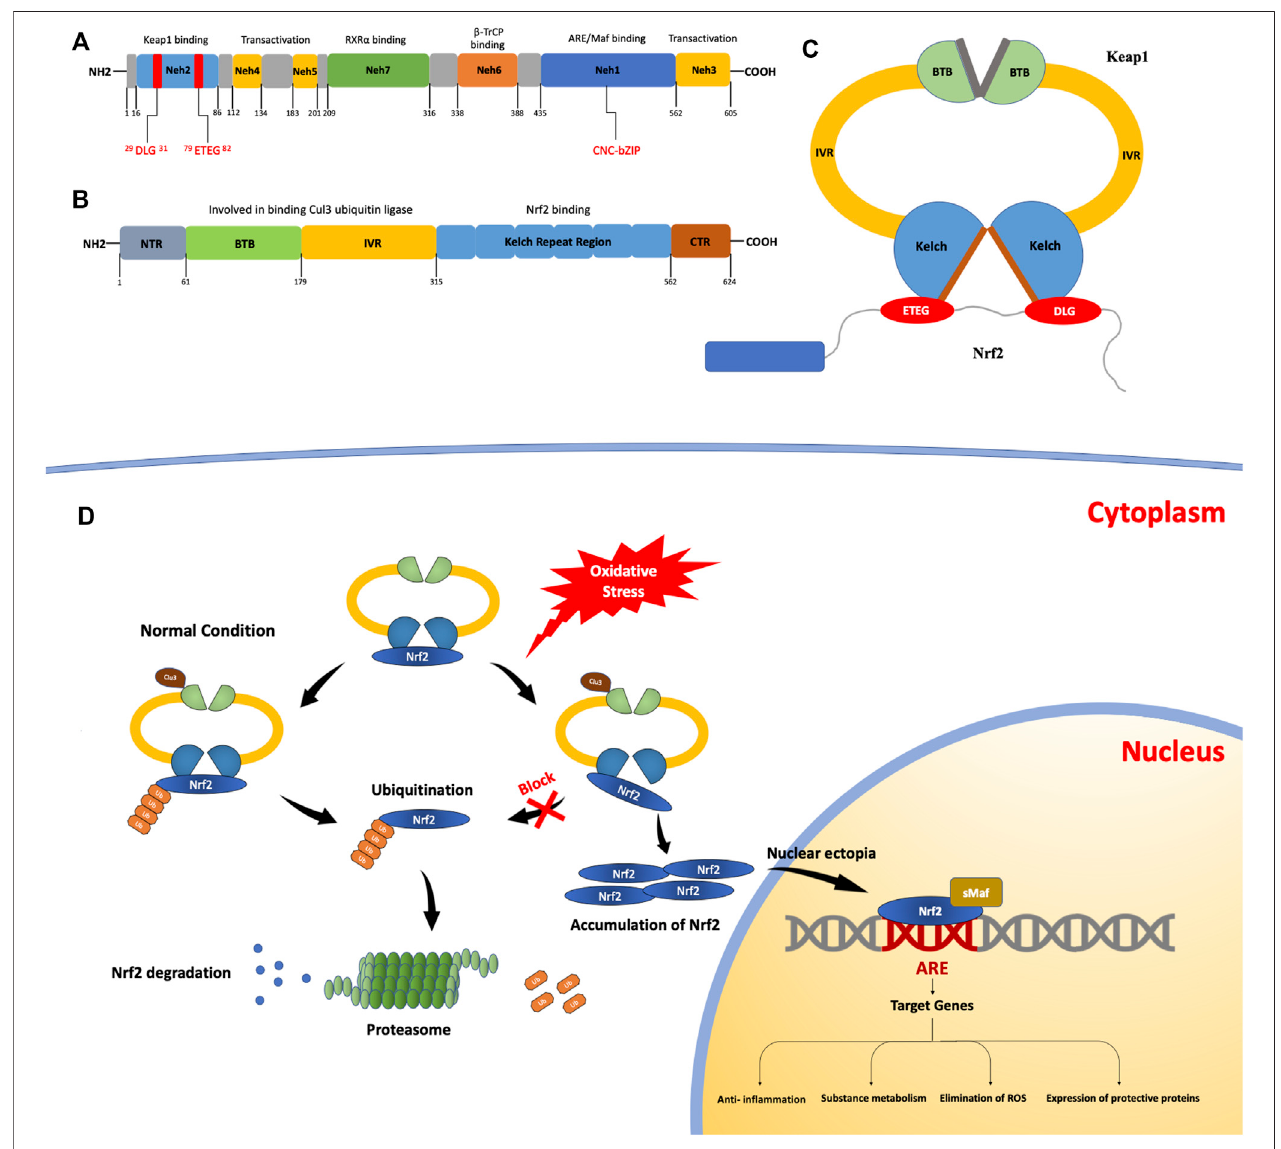
FIGURE 1 | The structures and processes involved in fi brosis. (A) Structure of the nuclear erythroid 2-related factor 2 (NRF2) protein. The NRF2-epichlorohydrin (ECH) homology (Neh) 1 domain contains a base sequence of cap-n-collar type basic leucine zipper DNA, which assists in the nuclear transfer of NRF2. The Neh2 domaincontainstwomotifsthatbindtoKelch-likeECH-associatedprotein1(KEAP1):ETGEmotifswithhighaf fi nityandDLGmotifswithlowaf fi nity. (B) Thestructureof the KEAP1 protein. KEAP1 is a homodimer. (C) It contains a Kelch repeat region that combines two motifs (ETGE and DLG) with different af fi nities to form a hinge – latch structure. The ETGE motif has high af fi nity and is considered a “ hinge ” . The DLG motif has a low af fi nity and can be regarded as a “ latch ” . (D) The KEAP1/ NRF2signalingpathway.Undernormalconditions,NRF2bindstoKEAP1toforman ɑ -helicalconformationcontainingsevenlysineresiduesandthenactsasatargetfor the ubiquitination and cleavage of NRF2. After the ubiquitination of NRF2 by Cullin3 (Cul3), it is degraded and free KEAP1 is involved in the next round of NRF2 binding and ubiquitination. When the oxidation equilibrium is disrupted, the binding of NRF2 and KEAP1 is also affected. The “ lock ” structure, namely the binding between the DLGmotifandtheKelchrepeatdomain,isdestroyed.Therefore,NRF2ubiquitinationisblockedandNRF2degradationisinsuf fi cient.AsNRF2continuestoaccumulate, free NRF2 is translocated to the nucleus. It can bind with antioxidant response elements to induce the expression of target genes, thus activating the body ’ s antioxidant defense and anti-in fl ammatory